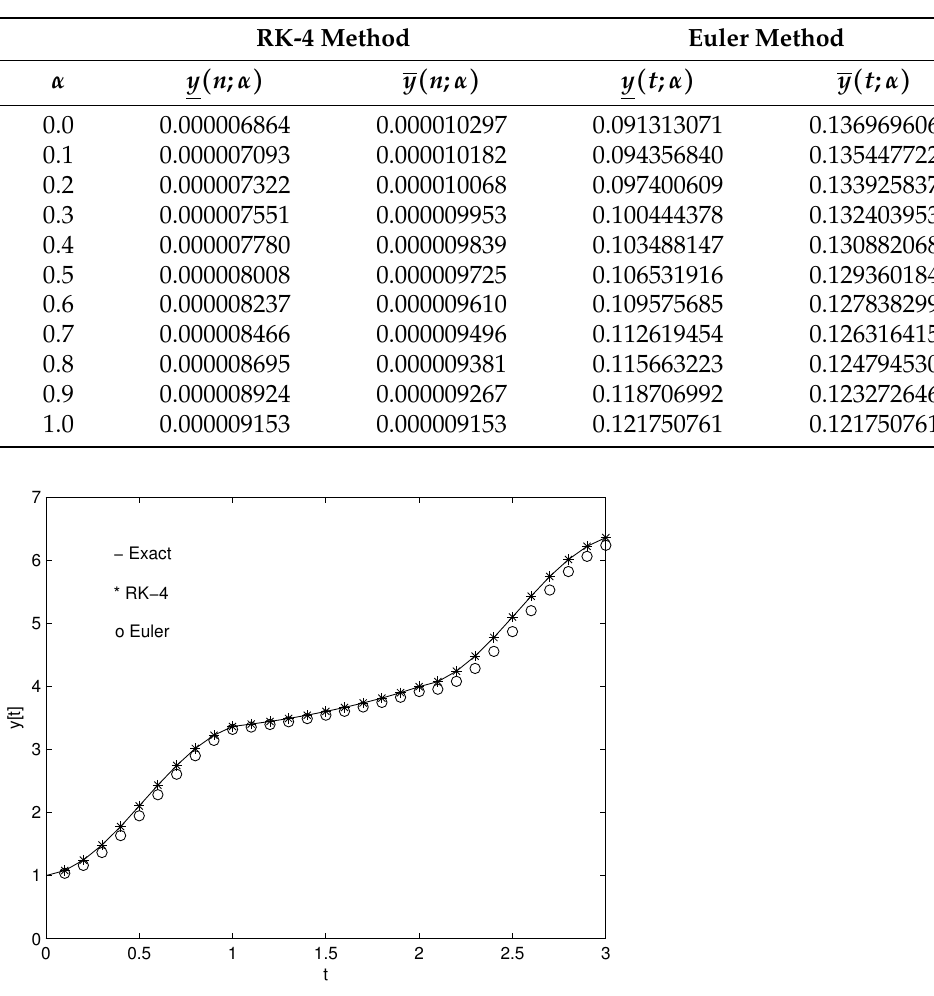
Table 3. Error analysis of approximate solutions by using the RK-4 and Euler methods for the indicated configuration.